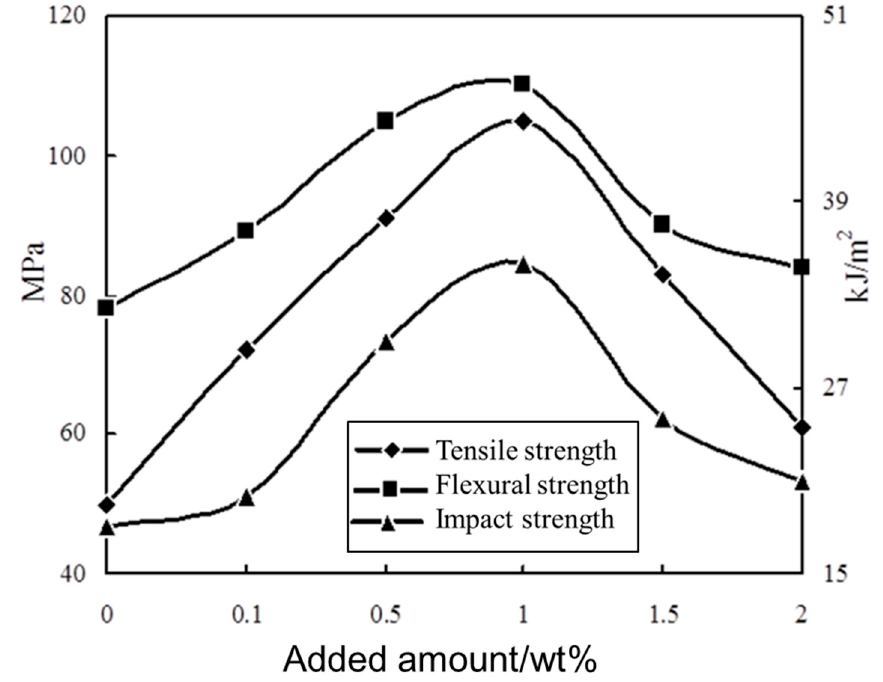
Figure 9. The effect of the added amount of intercalated sericite on the mechanical properties of the composites.